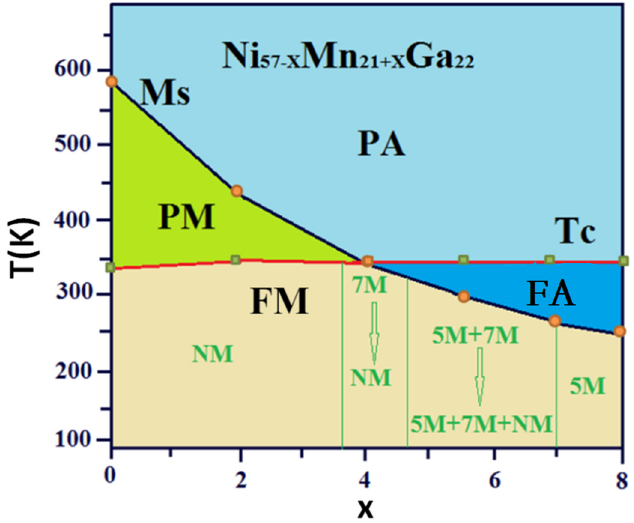
Figure 10. Phase diagram for crustal structure of martensitic phases above 100 K in Ni-Mn-Ga alloys.